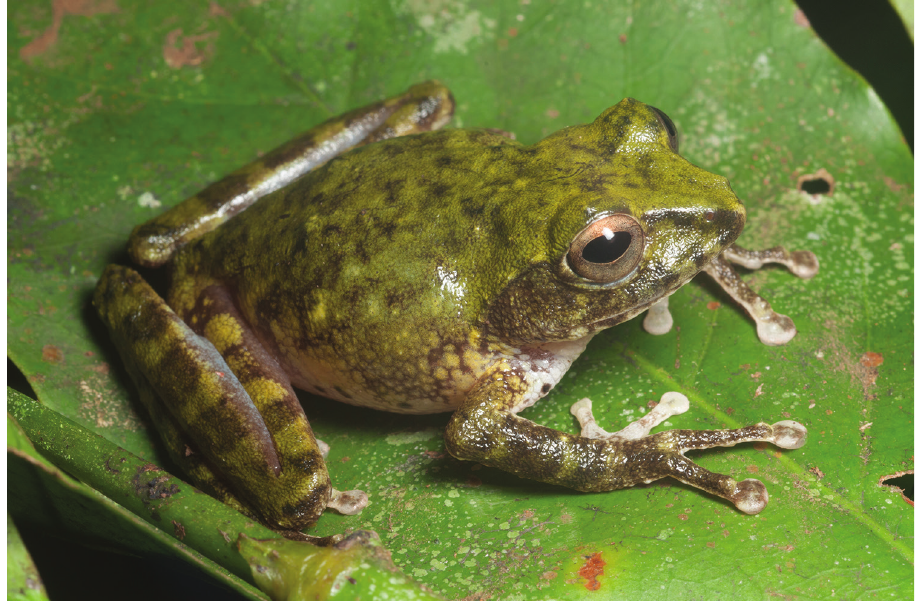
Figure 33. Philautus worcesteri male (KU 334207) from 1200 masl, Shrine Site, Municipality of Gin- goog, Mt. Lumot, Misamis Oriental Province. Photo: